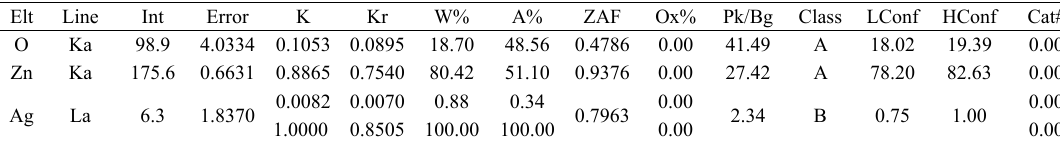
Table 3. Quantitative EDX results for ZnO/Ag bilayer thin films.